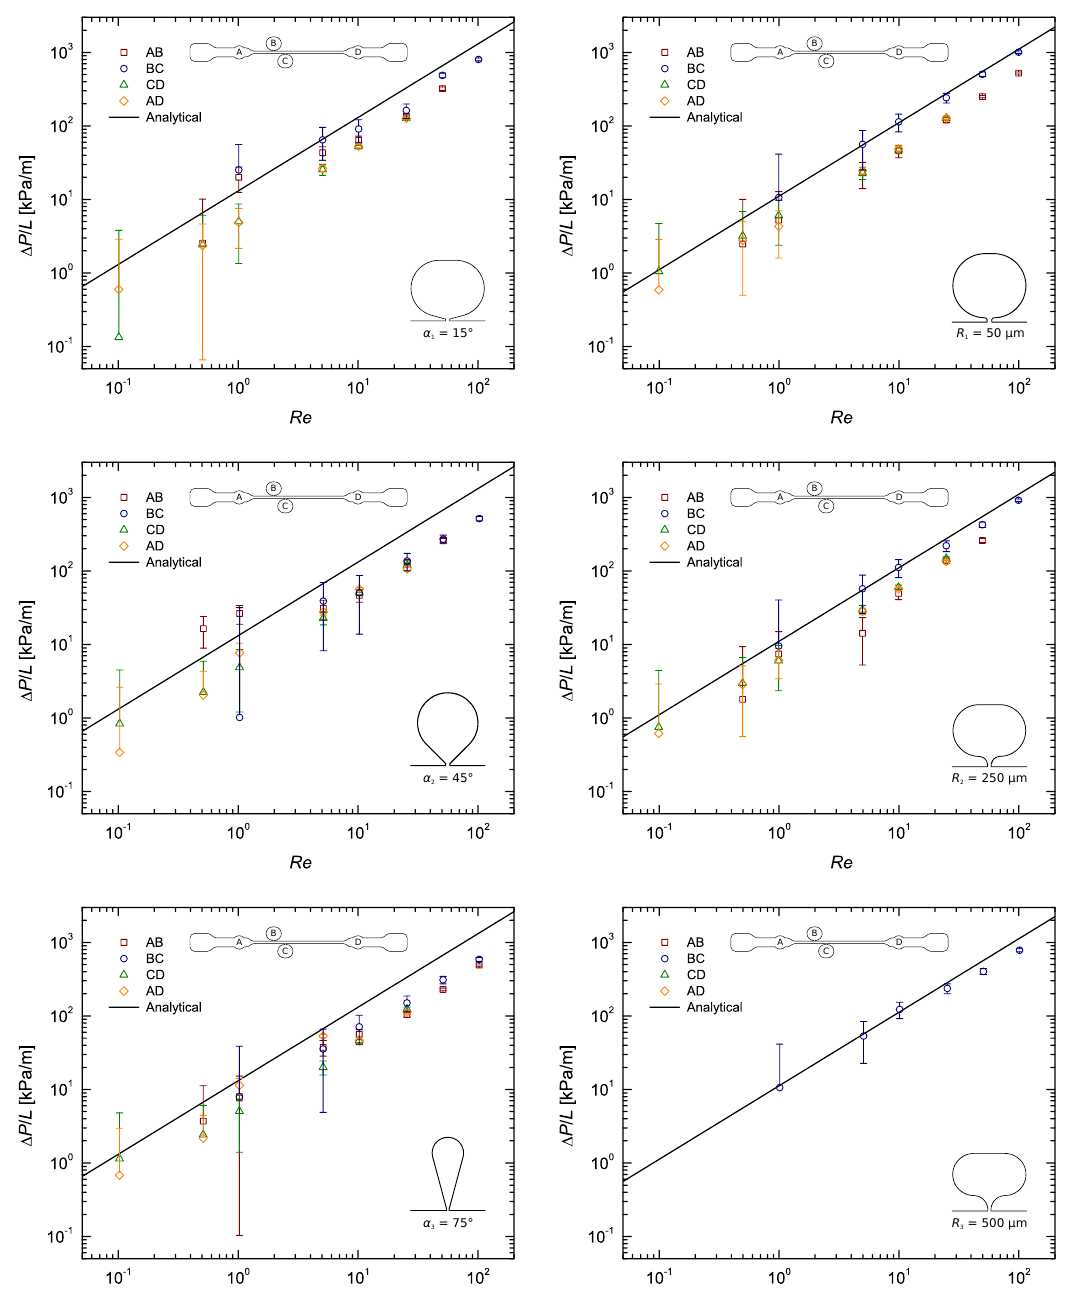
Figure A3. Pressure gradient as a function of the Reynolds number for the flow of DI water along a rectangular microchannel: Pressure taps with sub-channel width w 2 = 108 µ m; α taps on the left and R taps on the right (the lack of data in the bottom right panel was due to leakage